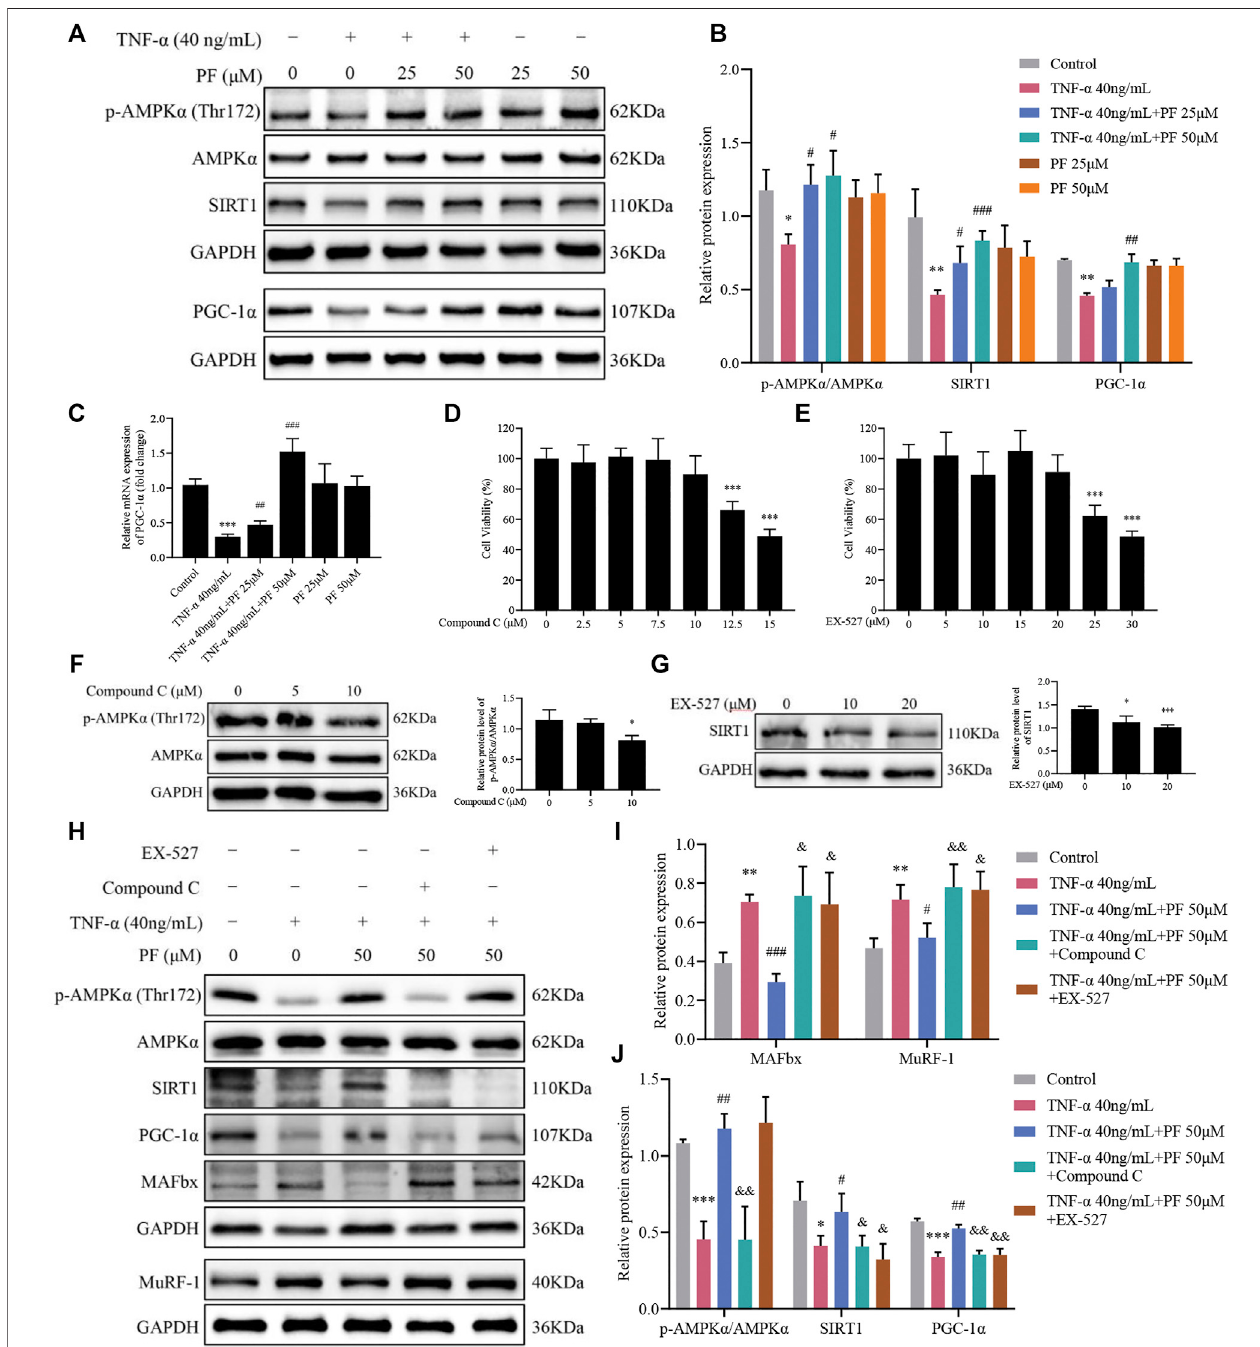
FIGURE 7 | PF activated the AMPK/SIRT1/PGC-1 α signaling pathway in C2C12 myoblasts induced by TNF- α . (A) Representative immunoblots using antibodies against p-AMPK α (Thr172), AMPK α , SIRT1, PGC-1 α and GAPDH. (B) Quanti fi cation of protein expression. (C) The mRNA level of PGC-1 α was assessed with RT – qPCR. (D) CytotoxicityofCompoundC(0,2.5,5,7.5,10,12.5and15 μ M)for24 h( n =6). (E) CytotoxicityofEX-527(0,5,10,15,20,25and30 μ M)for24 h( n =6). (F) TheeffectofdifferentconcentrationsofCompound Conp-AMPK α /AMPK α protein levels. (G) TheeffectofdifferentconcentrationsofEX-527onSIRT1 protein inhibition. * p < 0.05, ** p < 0.01, *** p < 0.001 compared with the compound or EX-527 0 μ M group. (H) Representative immunoblots using antibodies against MAFbx, MuRF-1, p-AMPK α (Thr172), AMPK α , SIRT1, PGC-1 α and GAPDH. (I, J) Quanti fi cation of protein expression. All protein expression was normalized to that of GAPDH asaloadingcontrol.Thedataarepresentedasthemeans±S.D. n =3,* p < 0.05,** p < 0.01,*** p < 0.001comparedwiththeControlgroup. # p < 0.05, ## p < 0.01, ### p < 0.001 compared with the TNF- α 40 ng/ml group, & p < 0.05, && p < 0.01, &&& p < 0.001 compared with the TNF- α 40 ng/ml + PF 50 μ M group.